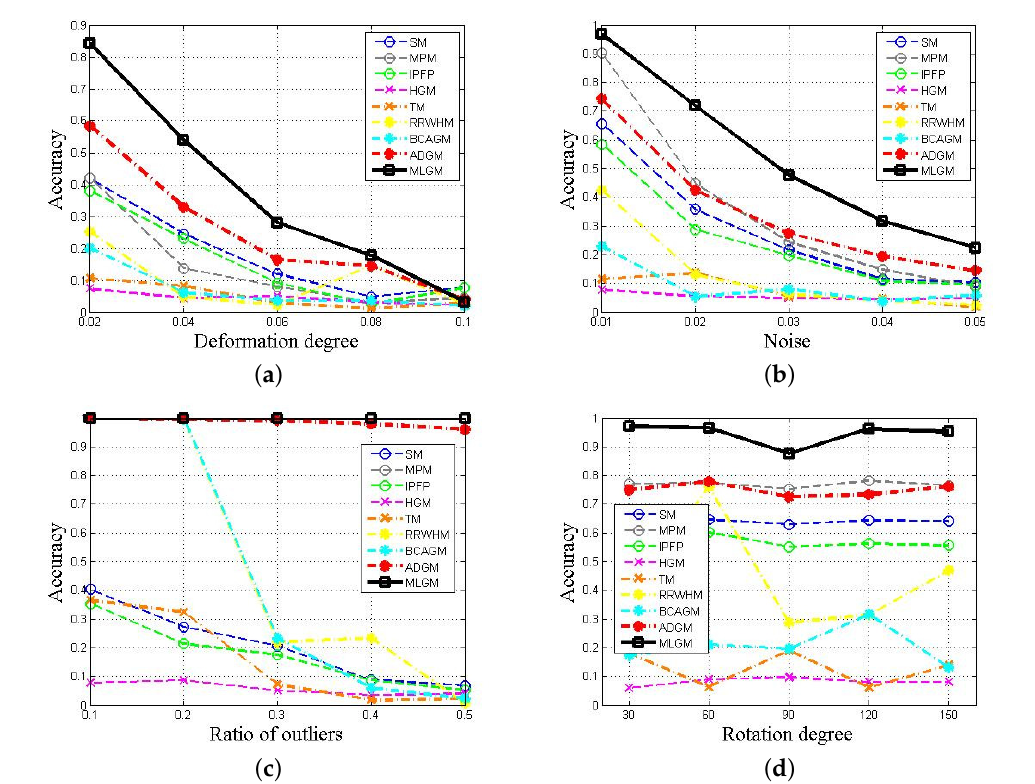
Figure 6. Accuracy comparison on the Blessing dataset. ( a ) Accuracy with different degree of deformation. ( b ) Accuracy with different noise level. ( c ) Accuracy with different number of outliers. ( d ) Accuracy with different rotation